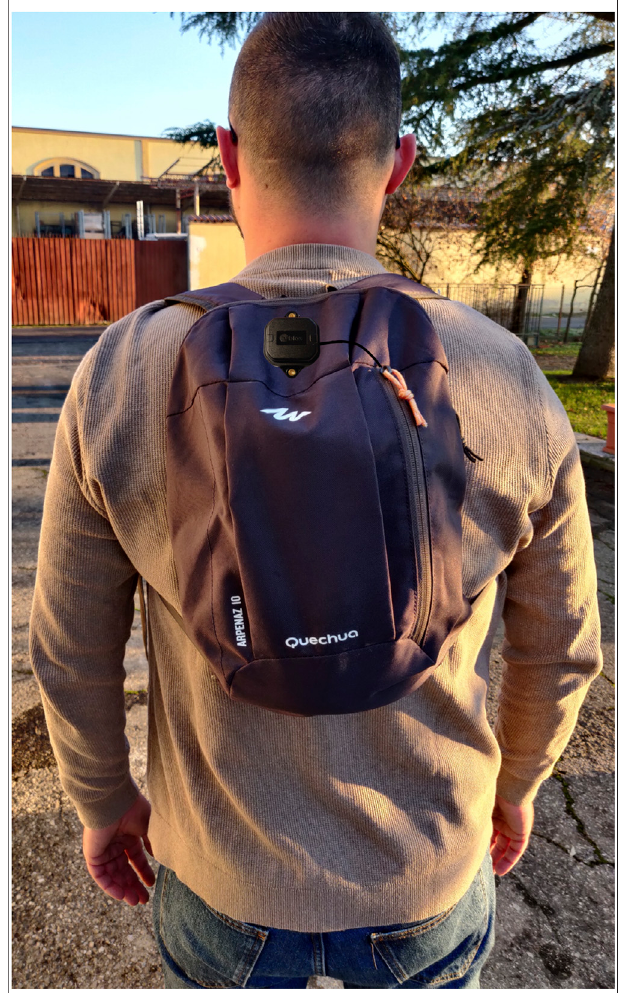
FIGURE 2 | Set-up of a